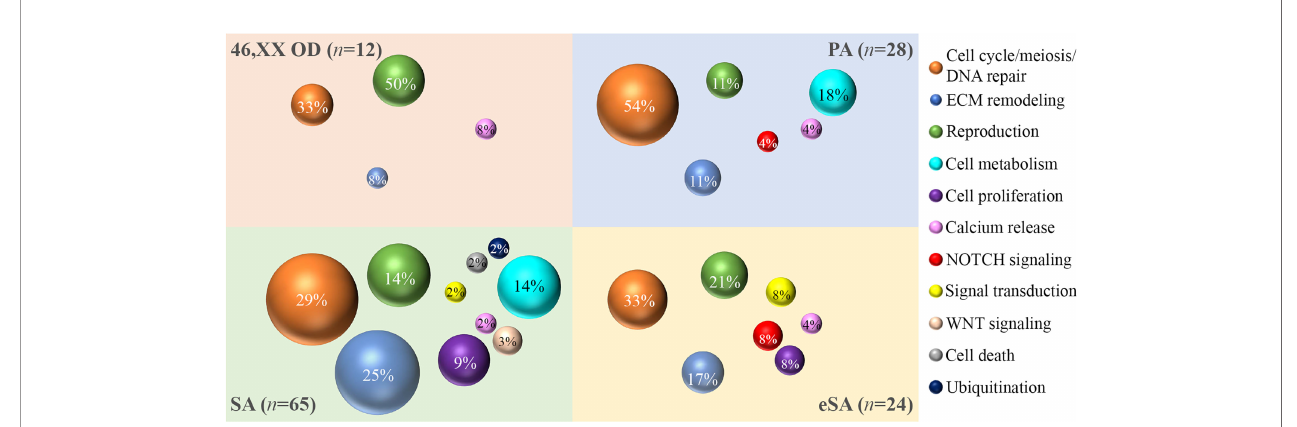
FIGURE 3 | Bubble chart of the pathways identi fi ed by the gene ontology analysis. The sample numerosity ( n ) is reported for each phenotype (46,XX OD, light red; PA, light blue; eSA, light yellow; and SA <25 years, light green). Pathways are represented by colored bubbles (refer to the legend on the right). The size of the bubbles depends on the number of variants identi fi ed in each pathway for each phenotype. The percentages within the bubbles indicate the ratio between the number of variants per pathway associated to a phenotype and the total of variants associated to that phenotype. 46,XX OD = ovarian dysgenesis with normal karyotype (46,XX); PA = primary amenorrhea with functional ovarian defect, eSA = secondary amenorrhea onset few months after menarche; SA = secondary amenorrhea <25 years of